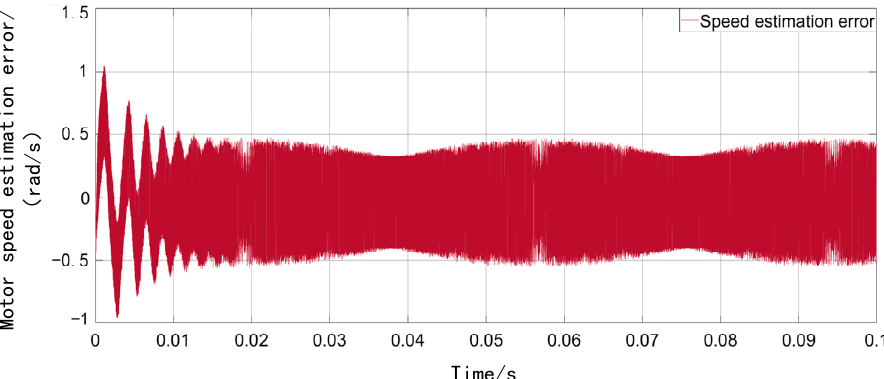
Figure 13. The variation curve of the speed estimation error of the traditional SMO at low speed.